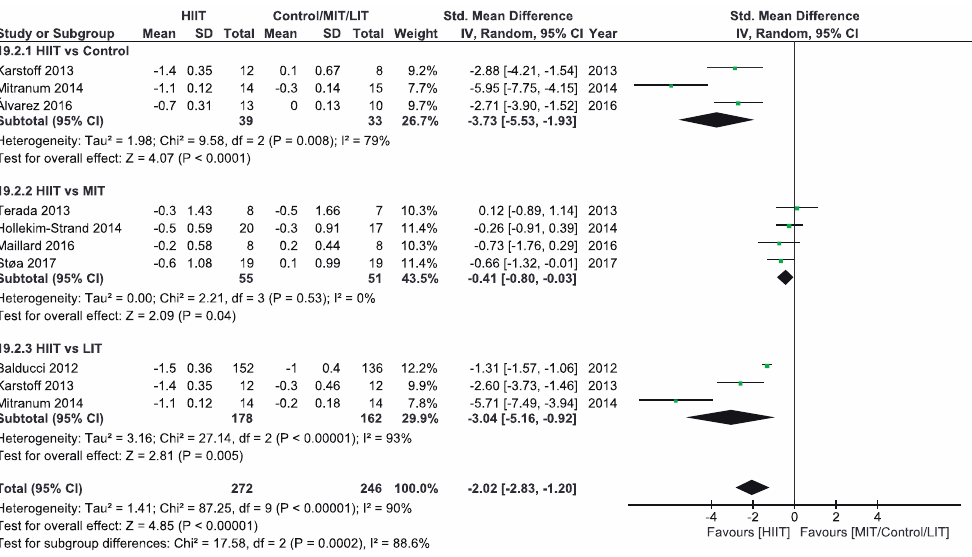
Figure 2. Forest plot for body weight. HIIT—high-intensity interval training, MIT—moderate-intensity training, LIT—low-intensity training, CI—confidence interval, IV—inverse variance, SD—standard deviation.